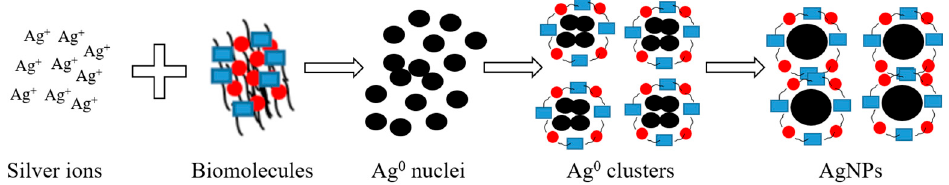
Figure 2. A schematic presentation of AgNPs synthesized using biomolecules extracted from plants.